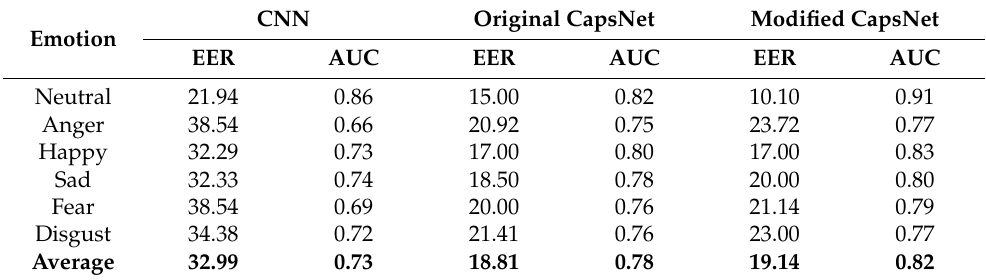
Table 4. Speaker verification performance in terms of EER and AUC of CNN, original CapsNet, and the proposed modified CapsNet using